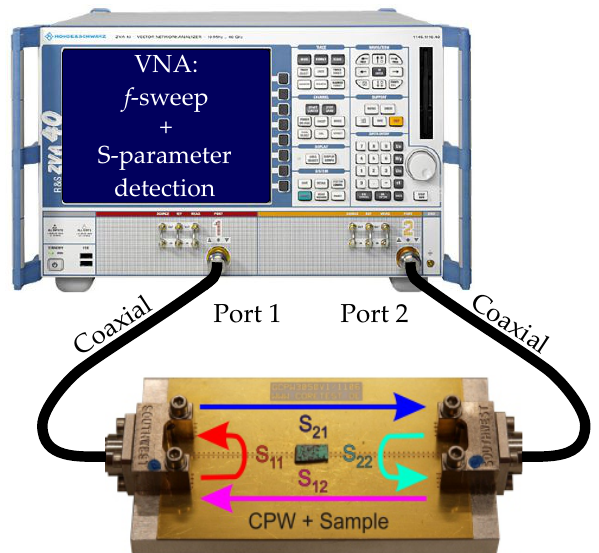
Figure 1. Components of a typical VNA-FMR spectrometer: A two-port VNA is connected to a CPW using coaxial cables and end launch connectors. The sample lies in the x – y plane face-down on top of the CPW with the x -axis along the CPW. An electromagnet (not shown) generates a static bias field H dc , whereas the microwave current flowing through the CPW generates a weak oscillating field h rf along the y -axis. The four S-parameters that can be detected with such a two-port setup are schematically shown as